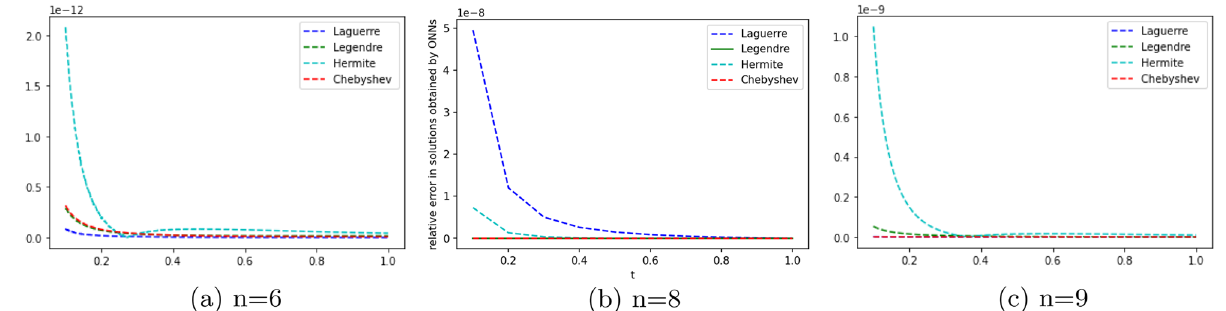
Figure 4. Error graph for different orthogonal neural networks with different numbers of neurons for Example 6.2.